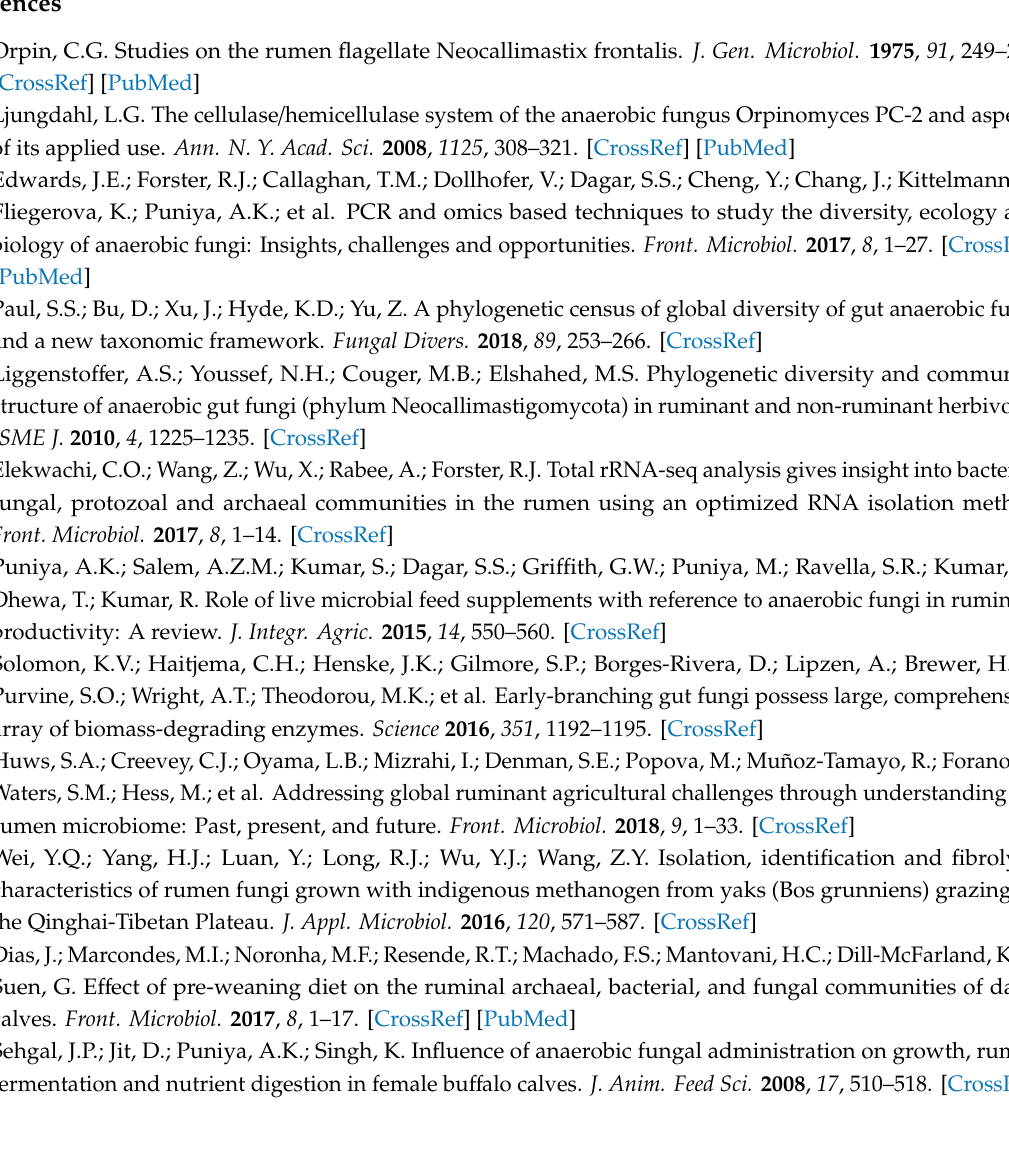
Figure S1: The significantly di ff erent phyla among three ruminant species, Figure S2: Genera with significant di ff erences in three ruminant species, Table S1: The distribution of sequences and OTUs in all samples, Table S2: The topological features at each ruminant